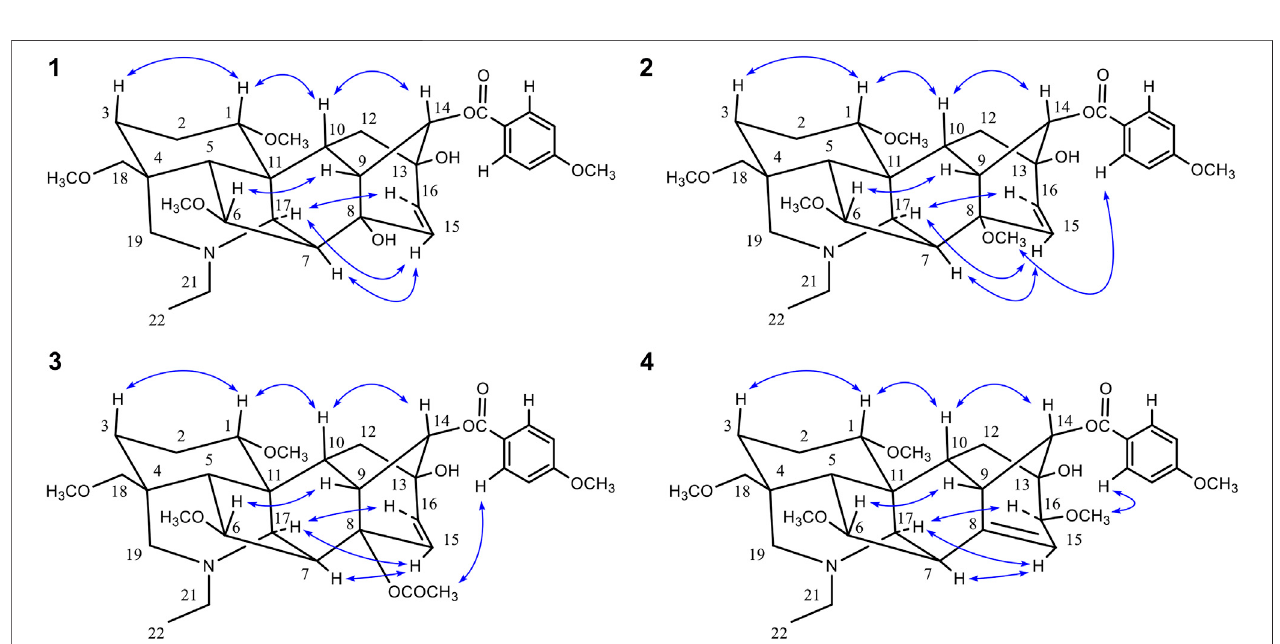
α -orientation. The NMR spectra of compound 1 lacked a methoxyl group at C-16, when compared with crassicauline A (Chen et al., 2002), and the 13 C NMR spectra of 1 clearly showed